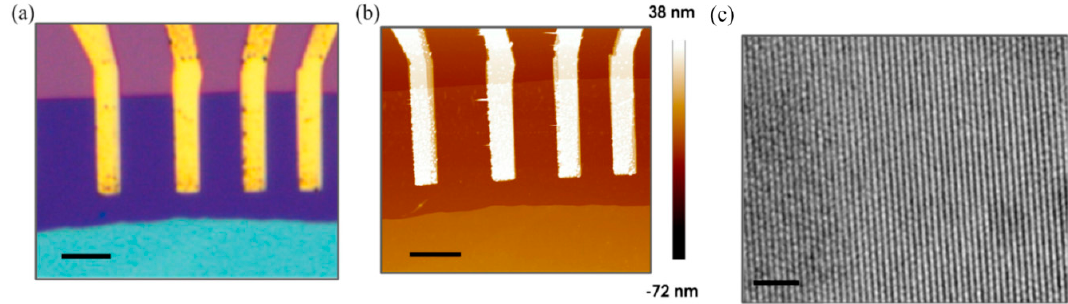
Figure 14. ( a ) Optical microscope image of the MoTe 2 field-effect transistor (FET). Scale bar is 5 μ m. ( b ) Atomic force microscopy (AFM) topography image of the MoTe 2 FET. Thickness of the MoTe 2 is 3.4 nm. Scale bar is 5 μ m. ( c ) High-resolution transmission electron microscopy (TEM) image of a